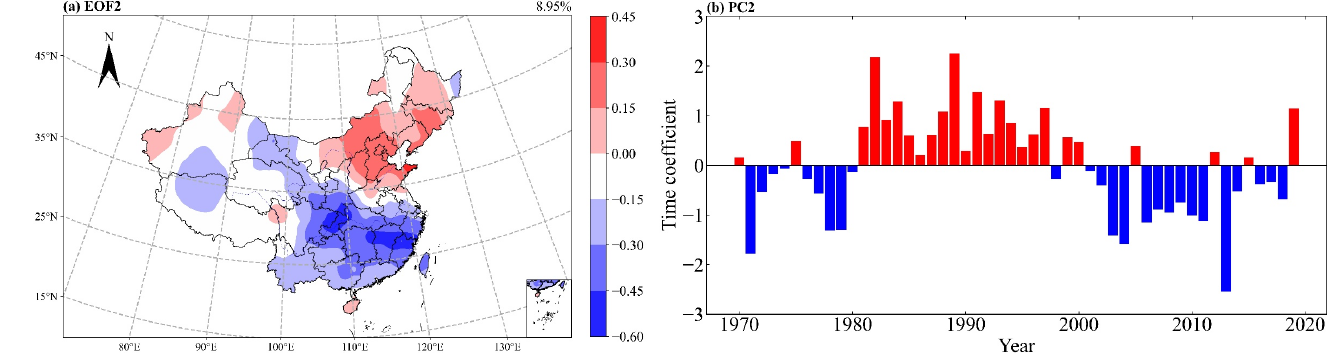
Figure 7. Spatial distribution ( a ) and time coefficient ( b ) of the second mode.